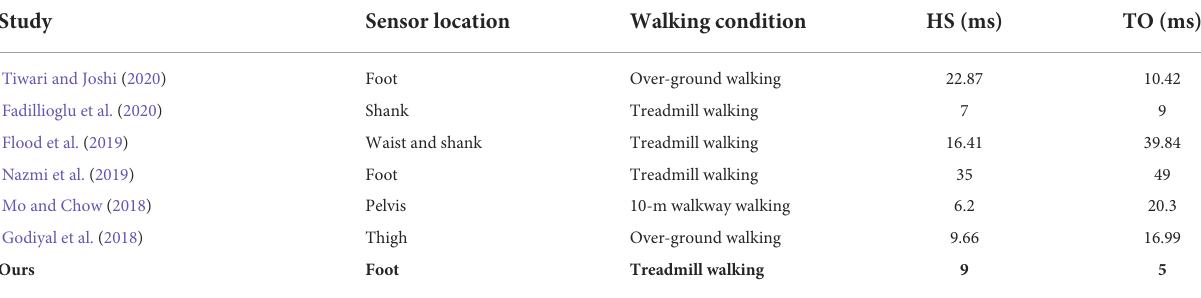
TABLE 3 A comparison of the MAE for HS and TO gait event detection in healthy participants with those reported in the literature.